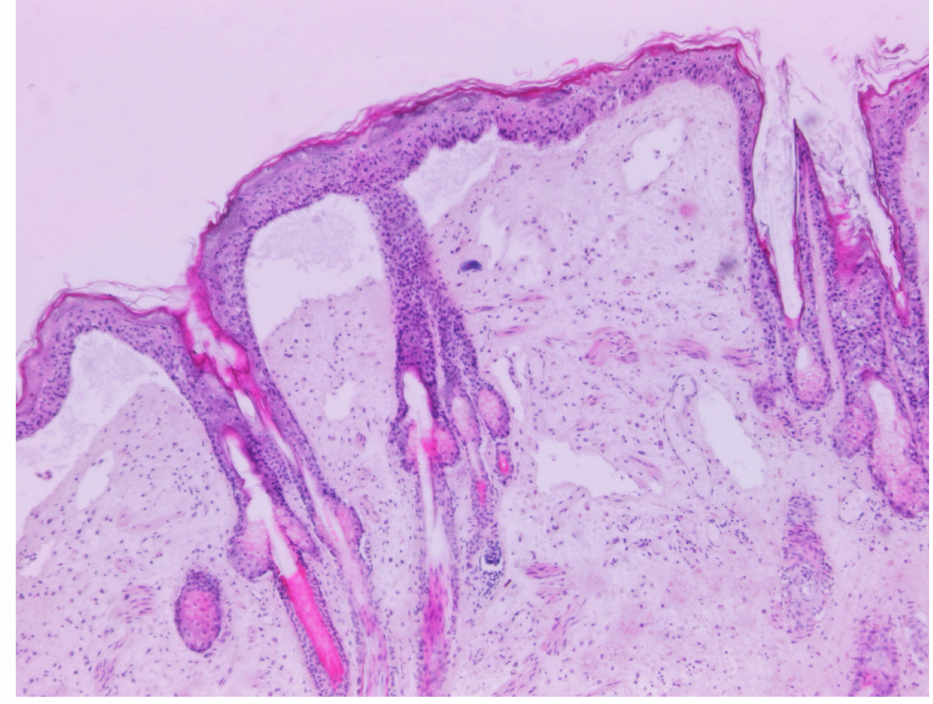
Figure 4. Microscopic finding in Male. Eyelid presenting oedema with epidermal detachment (H&E, 40 ×